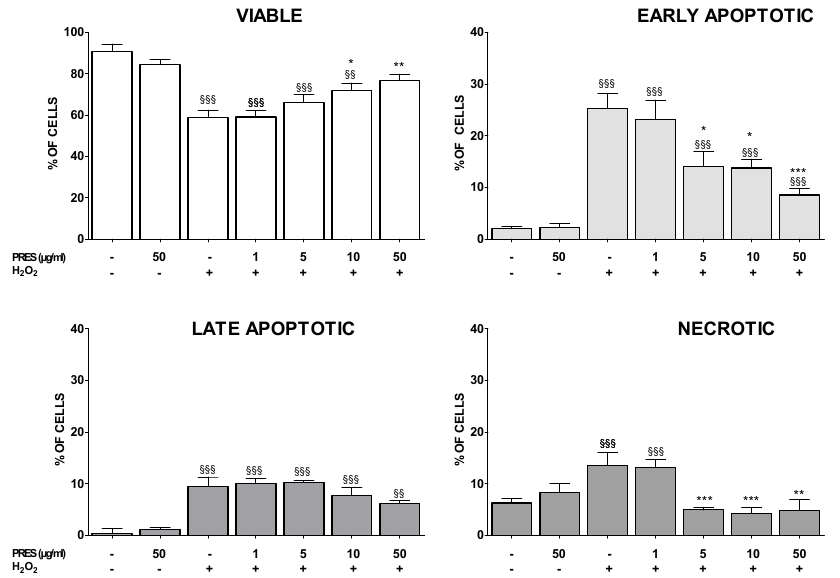
Figure 4. E ff ects of PRES on OS-induced apoptosis in SH-SY5Y cells. Cells were treated with PRES (1–50 µ g / mL) for 1 h OS and for the following 24 h. OS was reproduced by using H 2 O 2 (25 µ M for 1 h + 24 h with medium). At the end of the treatment, flow cytometric analysis of cells stained with Annexin V and propidium iodide (PI) was performed. Viable: cells negative for both PI and AV. Early apoptotic: cells positive for annexin V and negative for PI. Late apoptotic: cells positive for both PI and AV. Necrotic: positive for PI and negative for AV. Data are reported as means ± SEMs. §§ p < 0.01, §§§ p < 0.001 vs. untreated cells; * p < 0.05, ** p < 0.01, *** p < 0.001 vs. H 2 O 2 (one-way ANOVA followed by Bonferroni post-test).